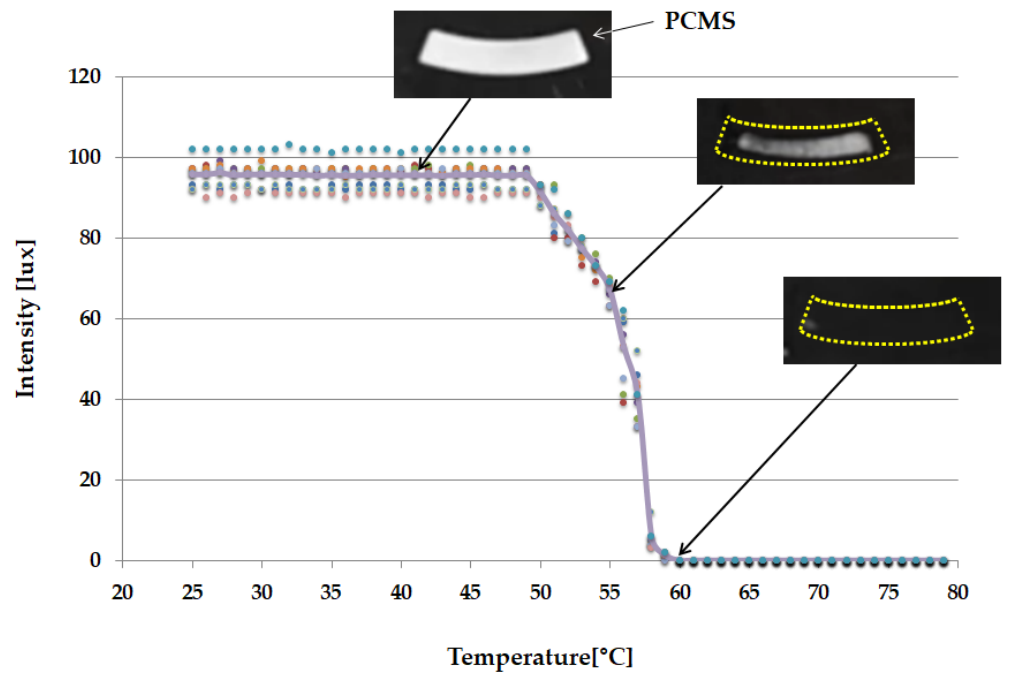
Figure 7. Graph showing the status of PCMS as the heating temperature increases. The PCMS is fully melt and transparent at around 60 °C.